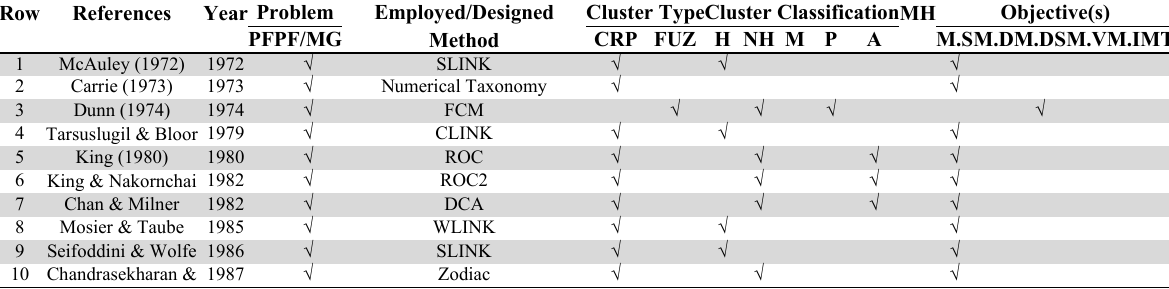
Details of methods used in opted references in clustering